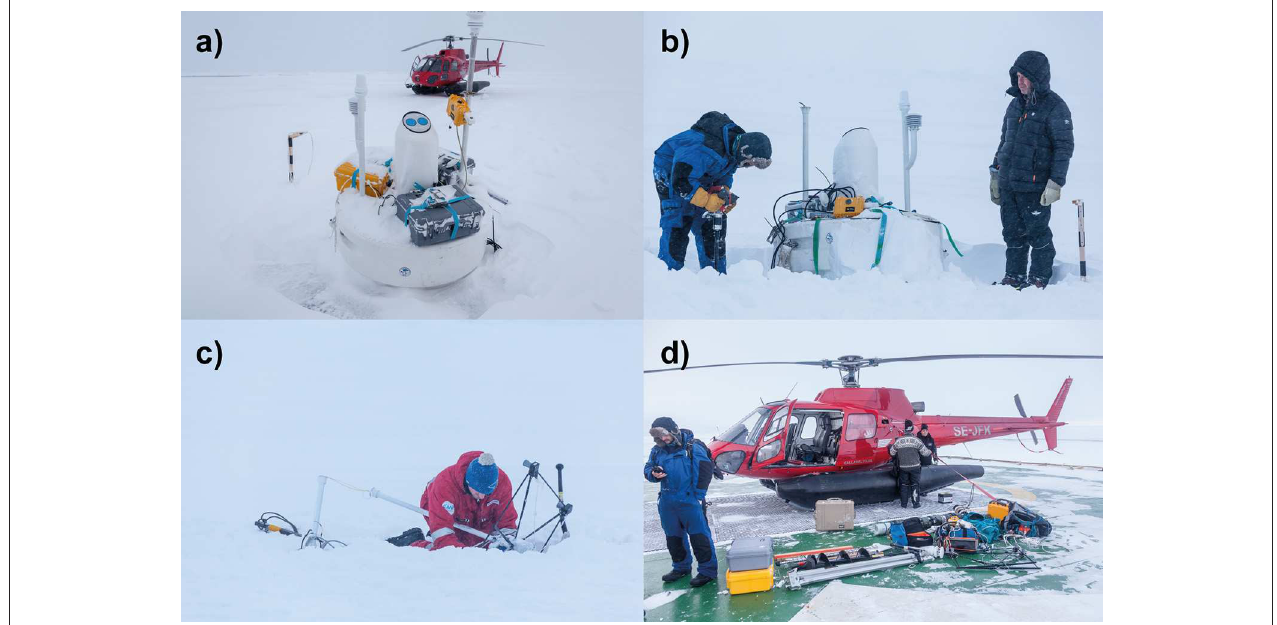
FIGURE 2 | (a) Initial state of surface buoy as found directly after landing. (b) Preparing recovery of the profiler by drilling a hole just next to the buoy. (c) Repairing a Snow Buoy that had been damaged by a polar bear. (d) All recovered equipment including all equipment used for the operation gathered on the helideck after